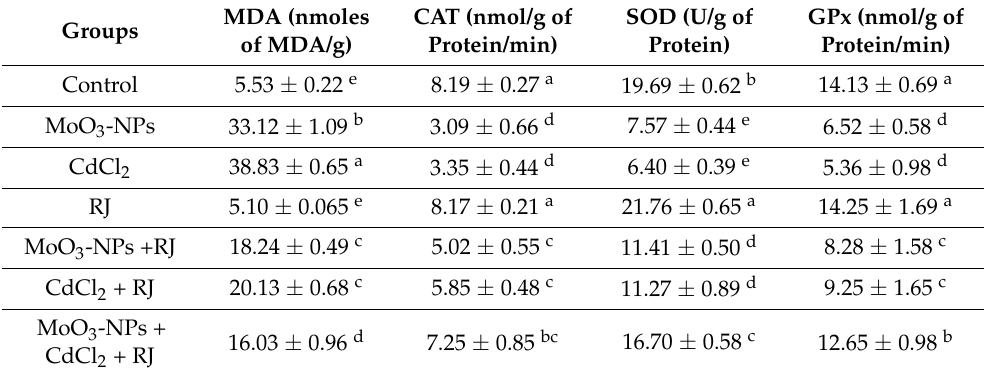
Table 4. The effect of Royal Jelly (RJ) on the oxidant and antioxidant status of male rats’ livers after treatment with molybdenum nanoparticles (MoO 3 -NPs), cadmium chloride (CdCl 2 ), and combina- tions of the two for 30 consecutive